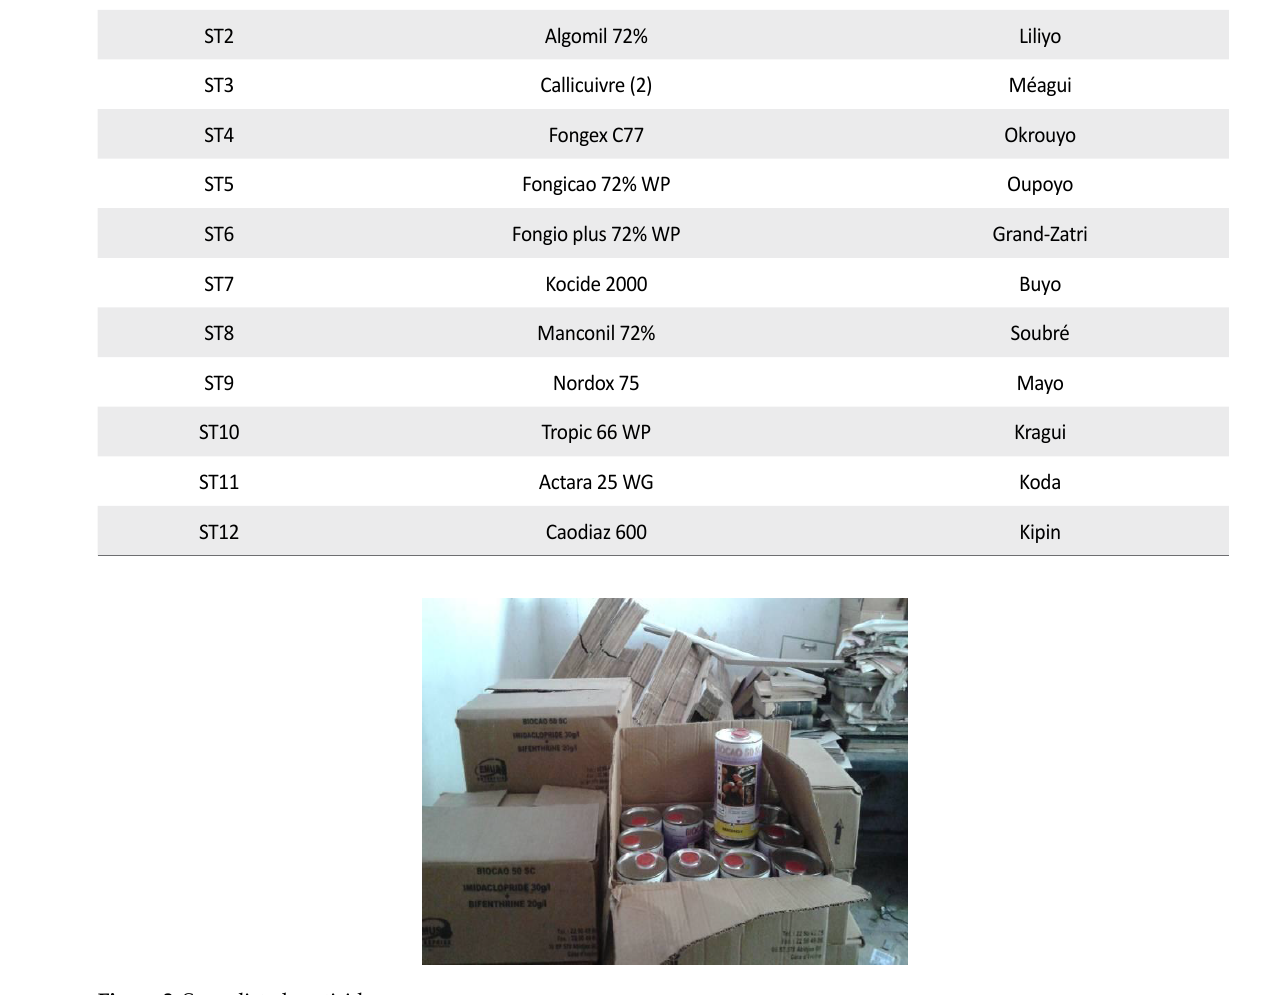
Odile BL, et al. Agricultural Inputs on Water-soil in Cocoa-growing Area. J Adv Environ Health Res. 2022;